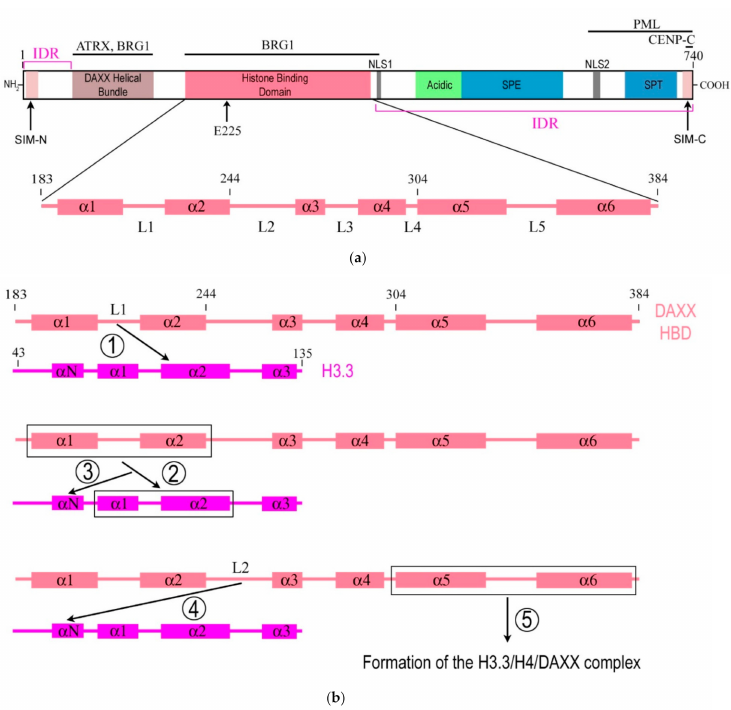
Figure 1. Simplified diagrams depicting the modular structure of the DAXX molecule ( a ) and interactions between the histone binding domain of DAXX and H3.3 during the formation of the complex H3.3/H4/DAXX ( b ). ( a ) DAXX contains two independent SUMO-interacting motifs at the N- and C-termini (SIM-N and SIM-C, respectively) [19]. The DAXX helix bundle serves as the